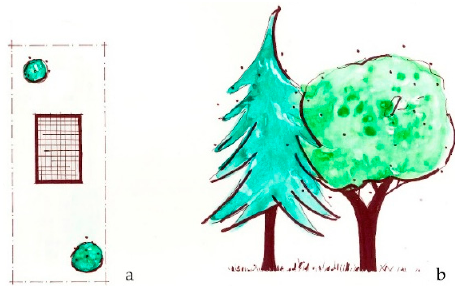
Figure 5. Retain the mature encourages retention of larger specimen trees as important components of the planted landscape, and that size and structure of trees are prioritized in green space planning. ( a ) Plan view of mature trees; ( b ) Elevation sketch of mature trees.